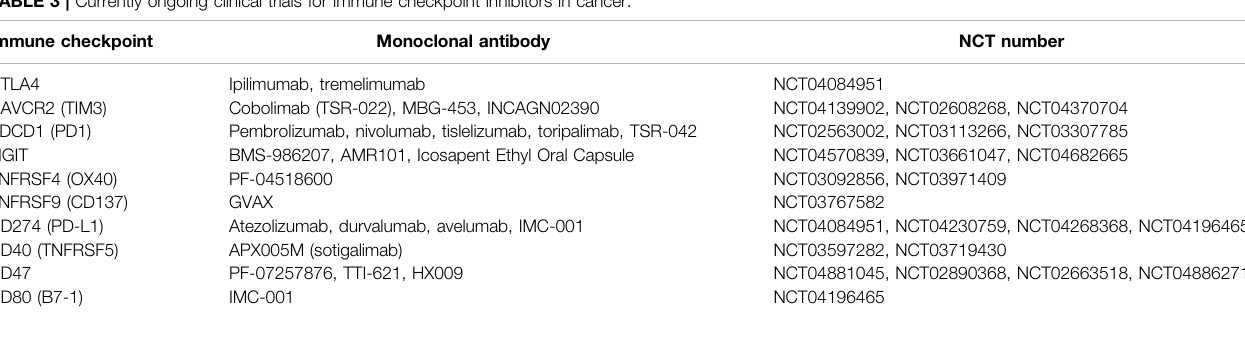
TABLE 3 | Currently ongoing clinical trials for immune checkpoint inhibitors in cancer.